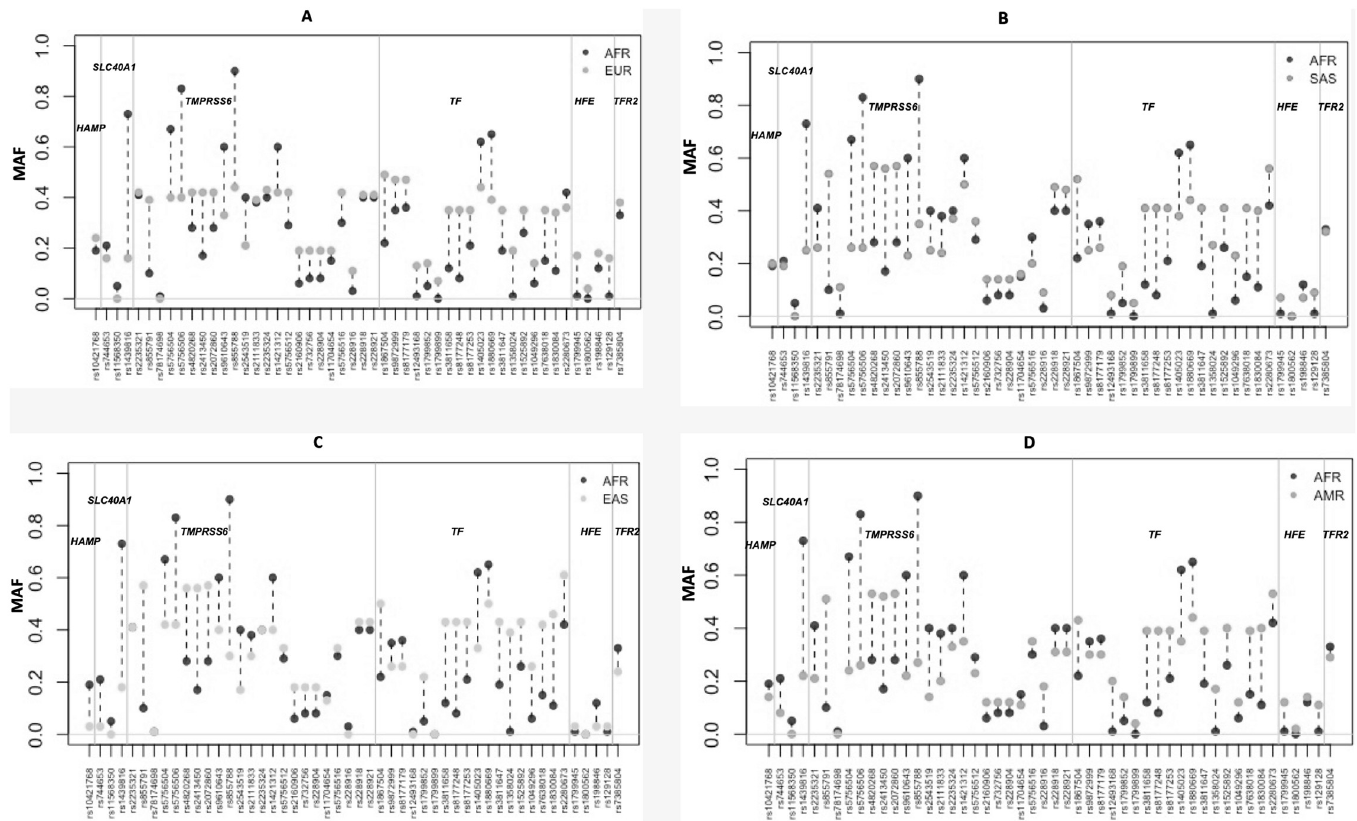
Fig 4. The differences in minor allele frequencies of SNPs in the six genes investigated, across different geographic regions. The comparisons were made between Africans and other global populations (A) Africa vs. Europe; (B) Africa vs. South Asia; (C) Africa vs. East Asia; (D) Africa vs. America. The thick grey lines indicated borders between SNPs in different genes: HAMP , SLC40A1 , TMPRSS6 , TF , HFE and TFR2 . The minor alleles were defined according to the 1000 Genomes Project database [34]. AFR, African; EUR, European; AMR, American; EAS, East Asian; SAS, South Asian.